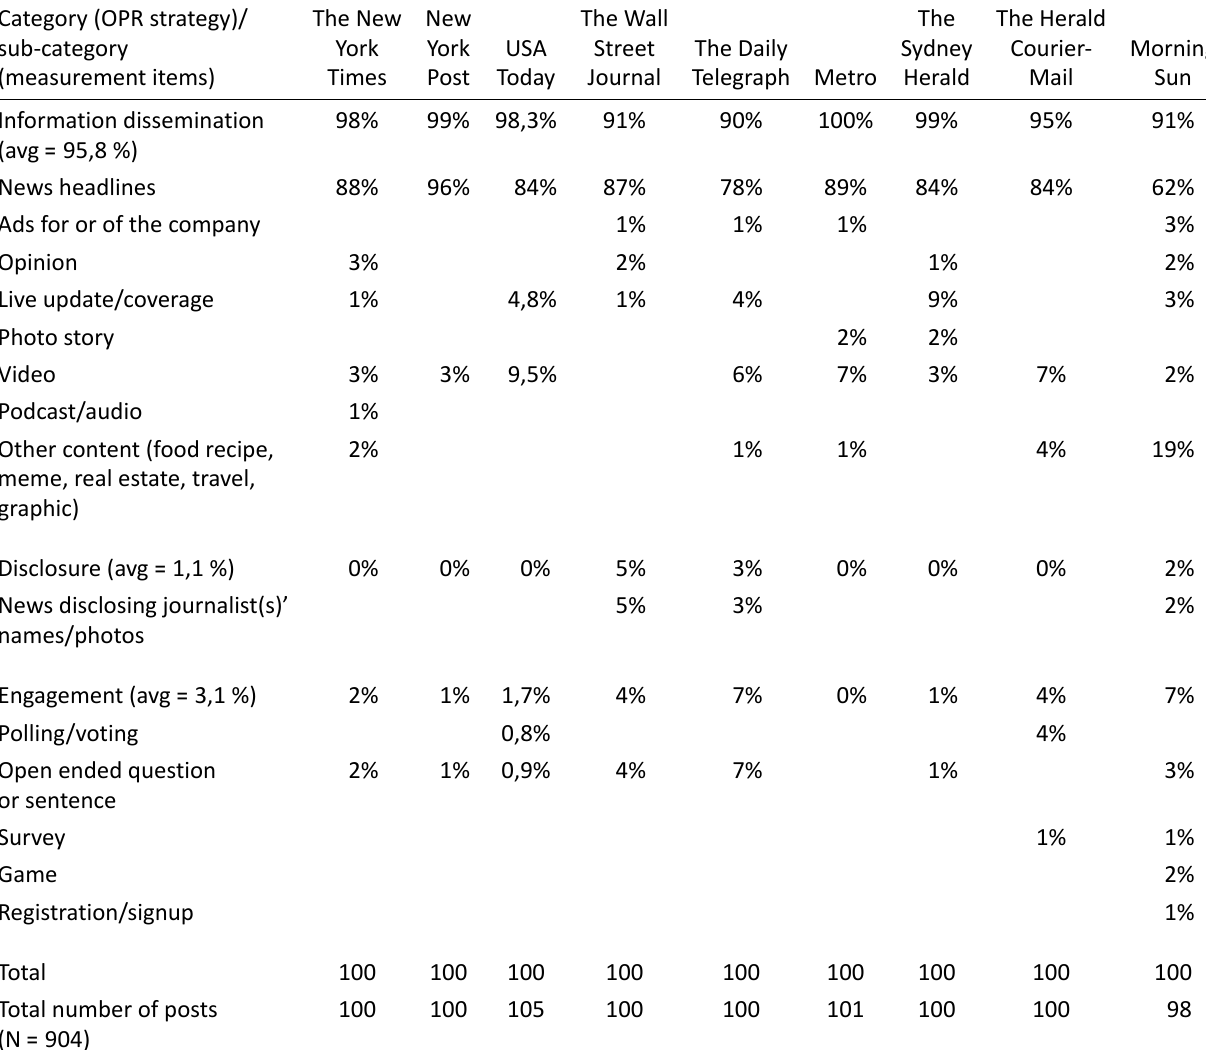
Table 2. The percentage of nine newspapers’ Facebook posts according to categories and sub‐categories (measurement items) of OPR